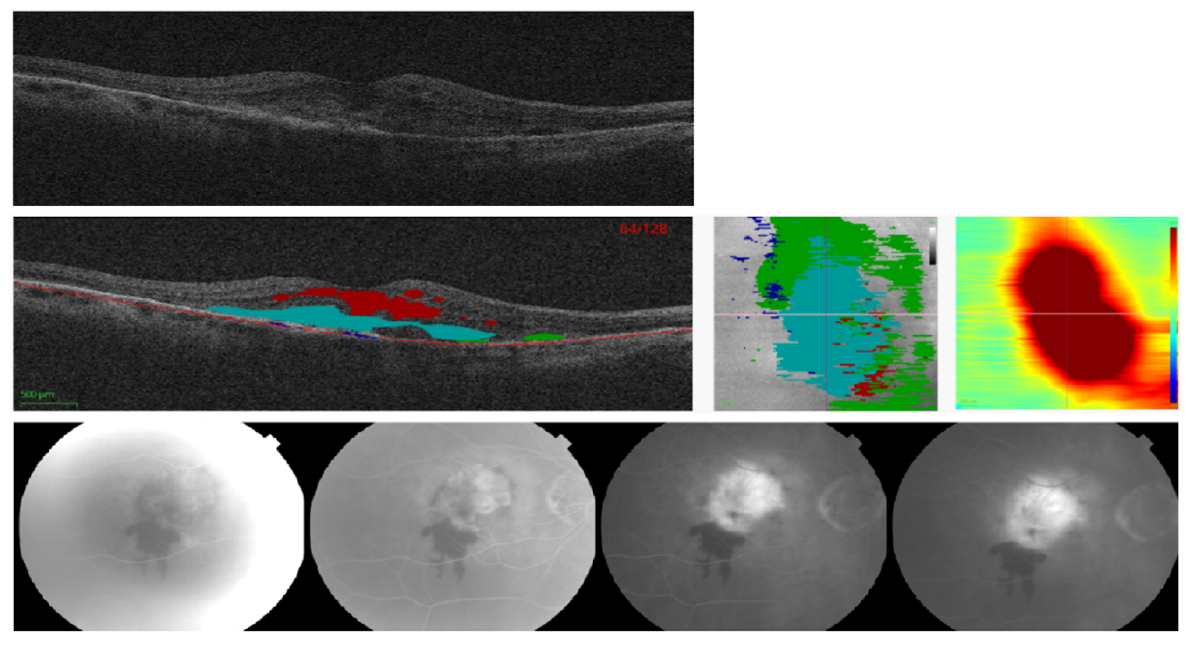
Figure 4. ( A ) Recursive feature elimination cross-validation. Optimal performance for predomi- nantly classic versus occult was reached with 101 features out of 106, and only 21 features were necessary to sustain the average model performance of 91% AUROC. ( B ) Distribution of the top 20 feature values in the training data (predominantly classic vs. occult classes). A . Representative case of predominantly classic CNV, as appearing on SD-OCT (true